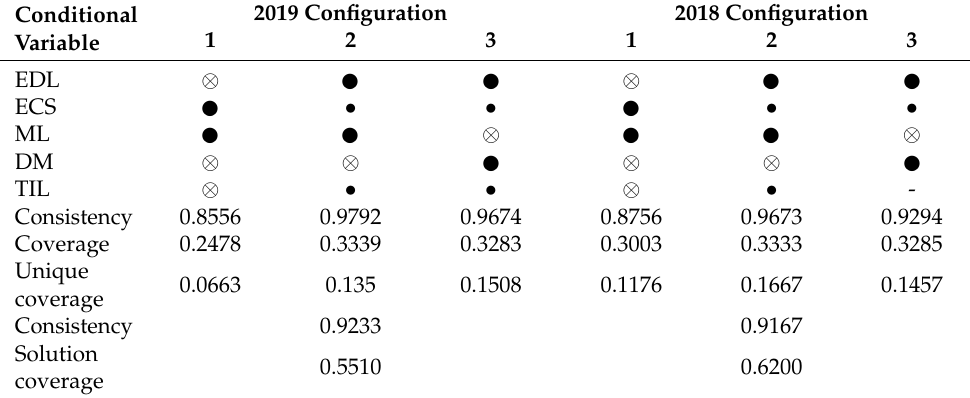
Table 7. High-efficiency configuration of regional